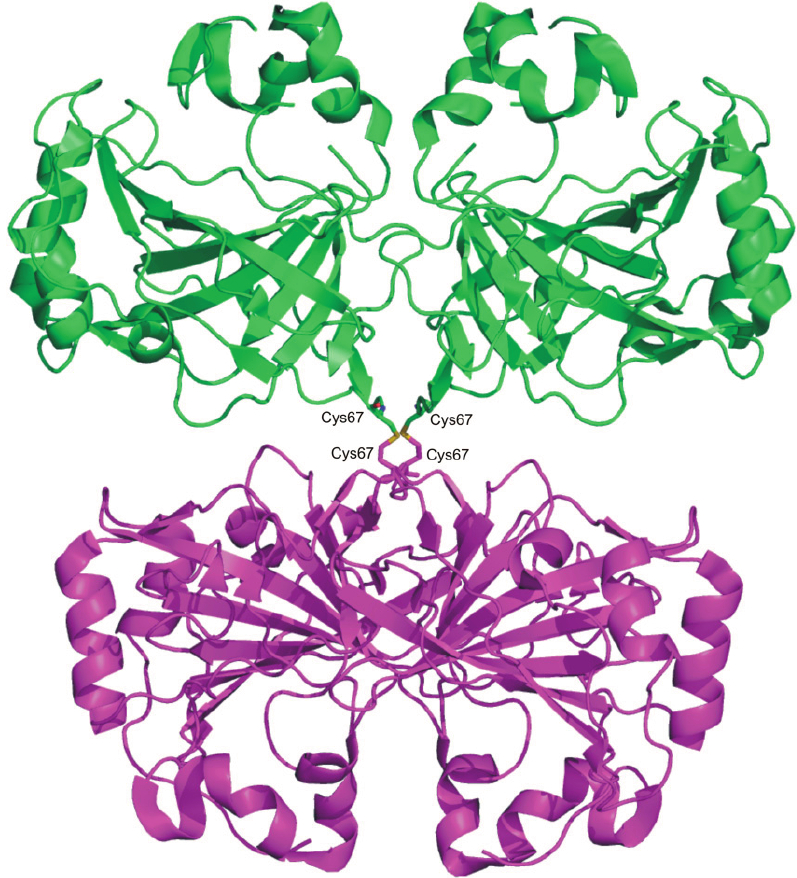
Figure 5. TaCA tetramer structure (PDB code 4C3T) with one dimer shown in green and the other one in magenta. Intermolecular disulfide bonds are also